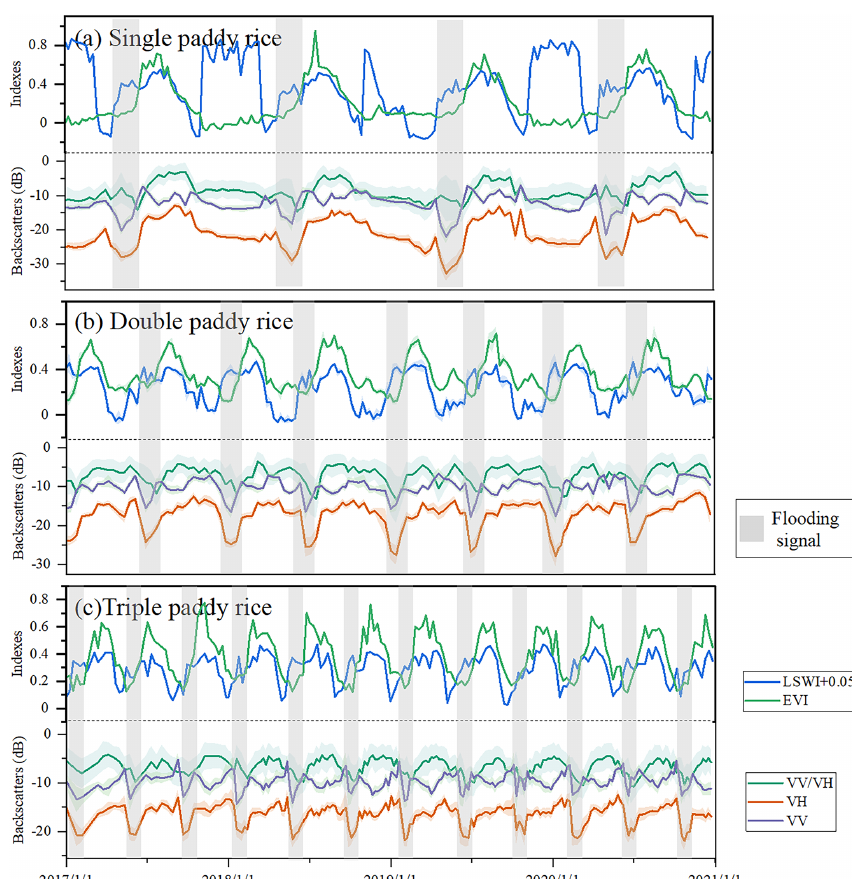
Figure 2. Temporal profile analysis of EVI, LSWI, VV, VH, and VH/VV ratio from three typical paddy rice sites with different lati- tudes during 2017–2020: (a) single paddy rice in Northeast China (46.804562 ◦ N, 131.896961 ◦ E), (b) double paddy rice in the Philippines (15.630637 ◦ N, 120.864242 ◦ E), and (c) triple paddy rice in Indonesia (8.6211997 ◦ S, 116.141157 ◦ E). The shaded areas indicate the stan- dard